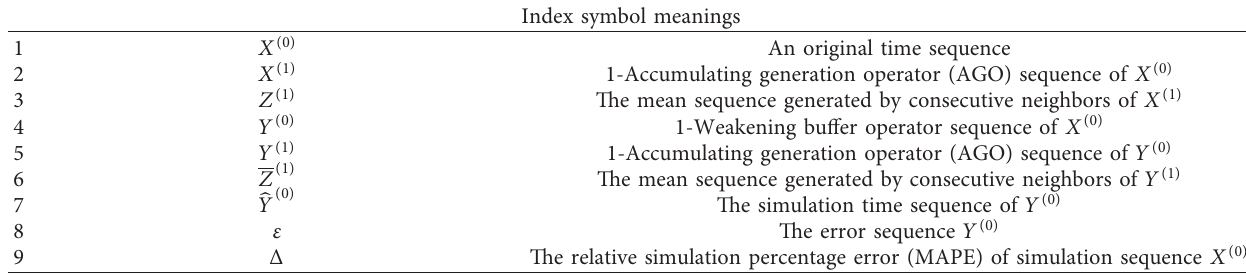
Table 1: Symbols and their meanings.